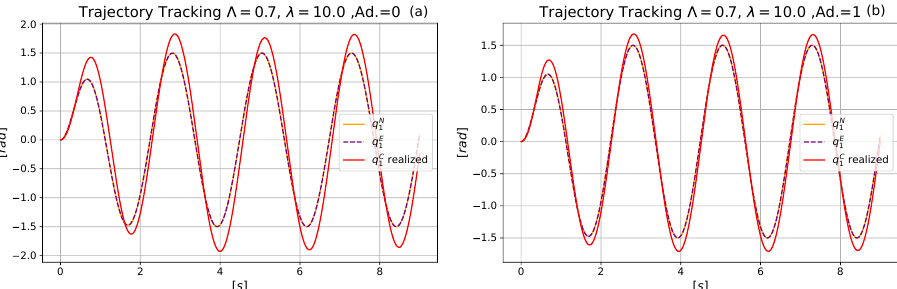
Figure 9. The operation of the adaptive controller in the lack of measurement noises. ( a ): The desired, deformed, and realized 2nd time-derivatives. ( b ): The angle of the adaptive abstract rotation.